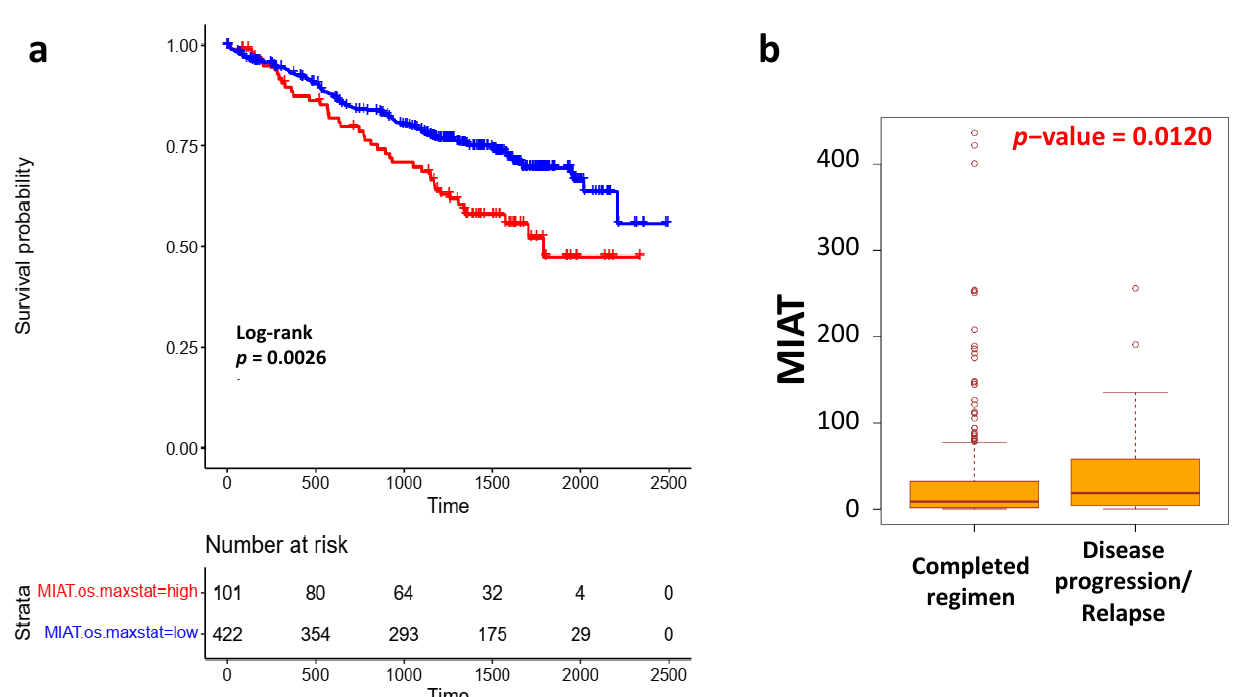
Figure 4. ( a ) Kaplan–Meier survival curve in 523 MM cases treated with bortezomib, bortezomib/IMIDs, or borte- zomib/IMIDs/carfilzomib in high compared to low MIAT group, according to previously defined max-stat cut-off relative to OS. Log-rank test p -value is reported. ( b ) Box plots of MIAT expression level in 287 MM cases that reached a completed regimen in comparison to 69 MM patients who experienced disease progression/relapse after bortezomib treatment. Differential expression was tested by the Wilcoxon rank-sum test with continuity correction.